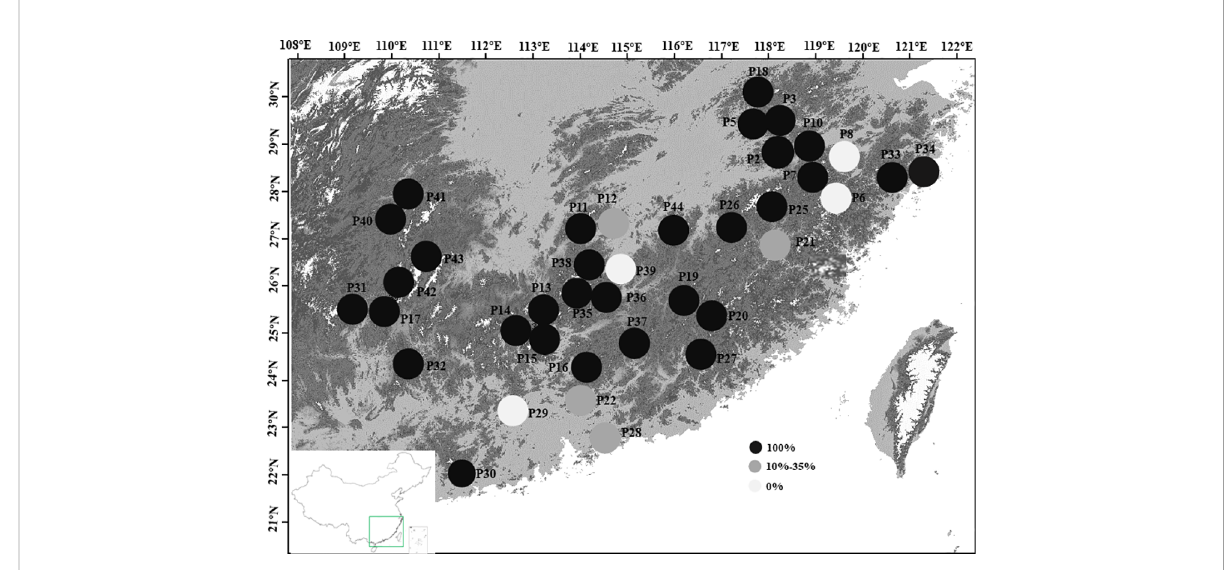
FIGURE 6 Proportion of private cpDNA haplotypes in 38 sampled populations of Wikstroemia monnula. The private haplotype is endemic to one local population and not to be shared by any other population. Haplotype information was from Zhang et al.,